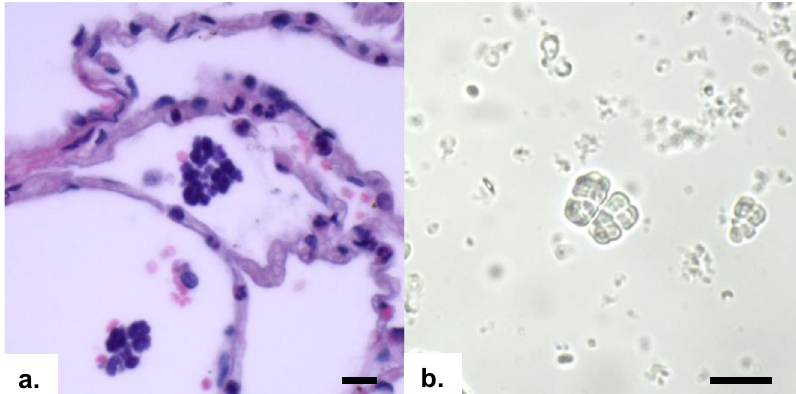
Fig. 6 Characteristic cuboidal packets of Sarcina -like organisms in tissues of ENGS-affected chimpanzees. a Basophilic packets of cells in a tetrad formation can be seen amongst and within alveoli of hematoxylin and eosin-stained lung tissue of one individual ( “ Jumu ” ). b Unstained brain tissue homogenate from another individual ( “ Joko ” ) contains highly refractile, cuboid packets of cells. Scale bars = 10 µ m. Micrographs are representative images of one of at least three sections ( a ) or smears ( b ) obtained from the same individual with similar